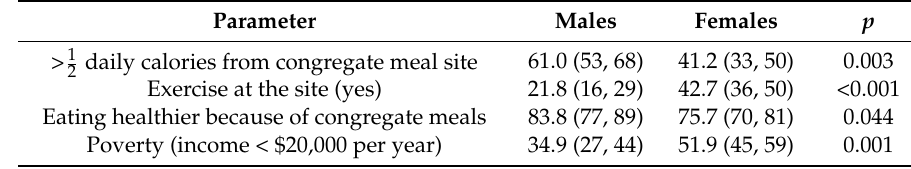
Table 4. Significant differences in health-related characteristics by sex.